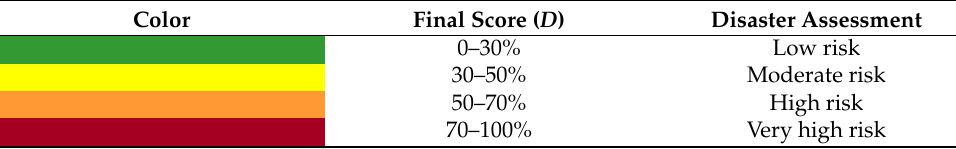
Table 10. Color table depending on the disaster assessment of tall buildings. Color